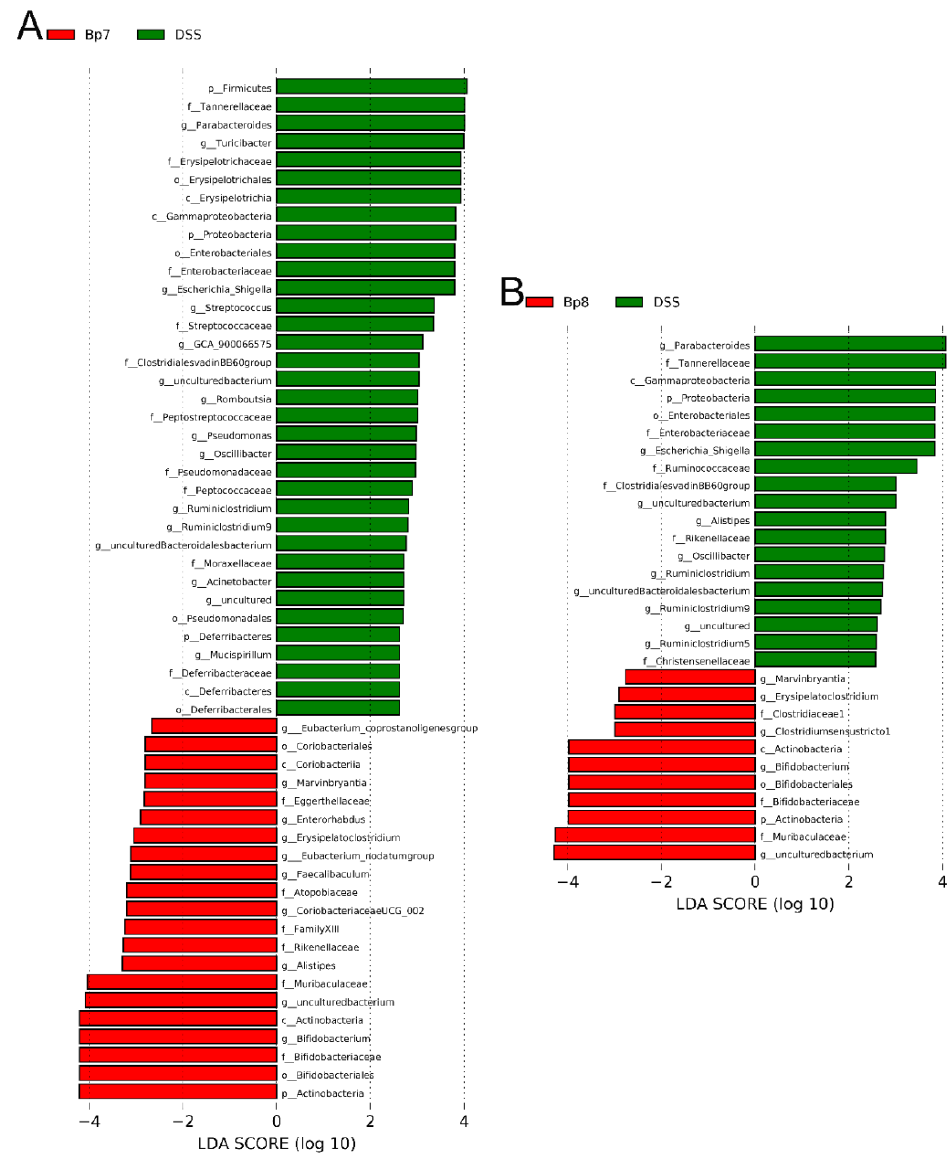
Figure 8. LEfSe analysis and linear discriminant analysis (LDA) score for taxa differing between Bp7 and DSS groups ( A ); Bp8 and DSS groups ( B ).